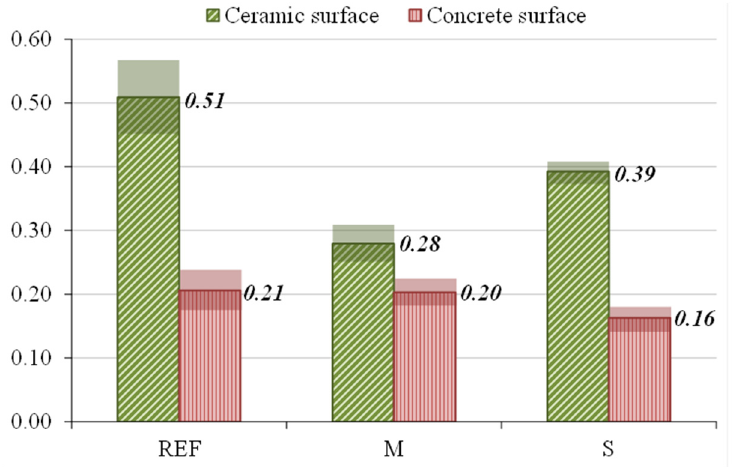
Figure 5. Average adherence and uncertainties of measures in ceramic and concrete surfaces in N/mm 2 .